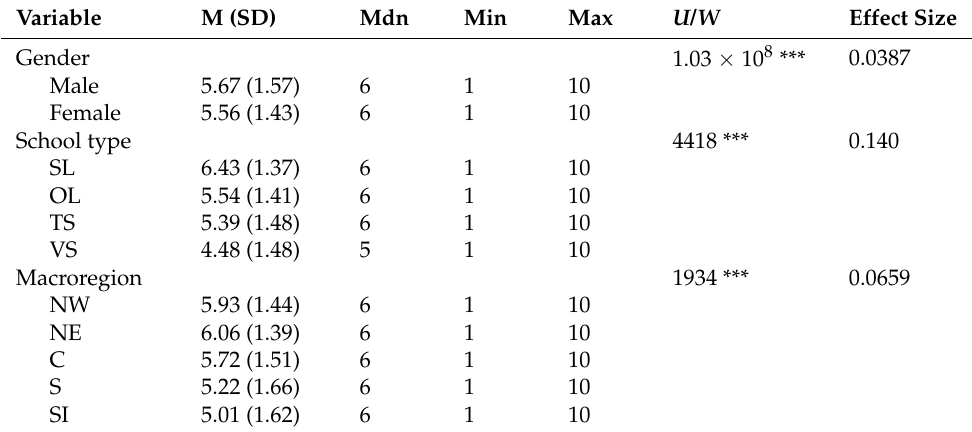
Table 7. The descriptive statistics divided among